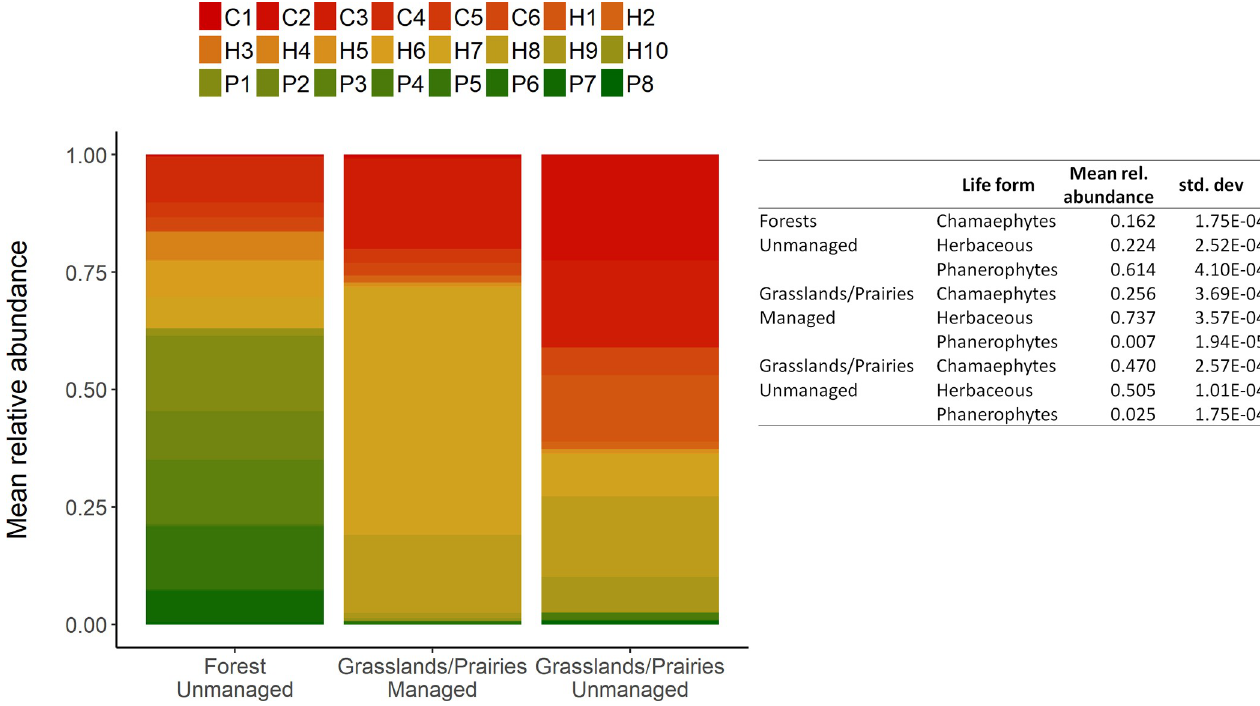
Fig 1. Plant functional group (PFG) relative abundances before disturbances. Bars show PFG relative abundances at the end of the initialisation phase, [ed by life form (colour-coded) and averaged by community type (unmanaged forests, managed and unmanaged grasslands) across the three simulation replicates. See Table C in S3 Appendix and Fig A in S4 Appendix for average relative abundances and standard deviations calculated per PFG.